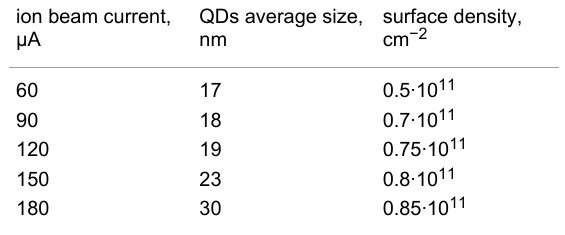
Table 2: Average size of QDs and surface density as a function of the ion beam current.